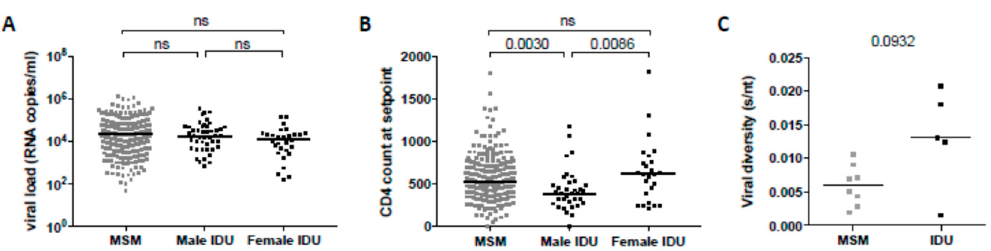
Figure 2. Clinical factors associated with the development of broadly neutralizing antibody responses in men and women in the MSM and IDU Amsterdam Cohort. Comparison between MSM, male IDUs and female IDUs for ( A ) viral load in plasma at setpoint and ( B ) CD4 + T cell counts at setpoint. Each data point represents one individual. Statistically significant differences between the different groups were determined using a Mann–Whitney t-test and the P-values are shown; ns, not significant. Horizontal bars represent the median value per group. ( C ) Early sequence env diversity is shown in substitutions / nucleotides (s / nt) for five IDU male versus eight MSM infected individuals. env sequences were obtained within the first three months post-SC. Each dot represents one individual and horizontal bars represent the median diversity per group. Table 2. Factors associated with the development of broadly neutralizing antibodies in participants of the Amsterdam Cohort. Univariate Analysis Multivariate analysis* p -value Effect p -value Effect Gender and route of transmission 0.002 − 0.16 0.001 − 0.12 CD4 + T cell count at setpoint 0.002 − 0.16 0.017 − 0.13 Viral load at setpoint 0.011 1.34 0.127 0.09 *The multivariable model was adjusted for the variables shown in the table.